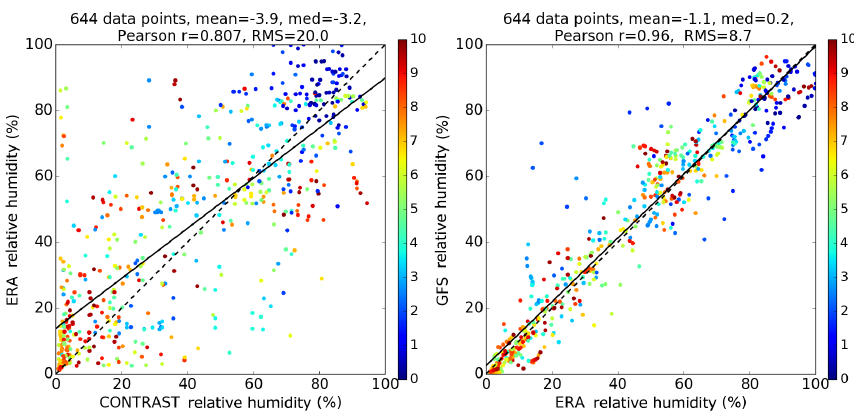
Figure 7. Scatter plots for RH for all 3h 600km collocation pairs for (left) ERA and CONTRAST on the 60s smoothed CONTRAST altitude grid and (right) GFS and ERA on the ERA (pressure) grid. The color indicates the altitude of the measurement (left: km; right: